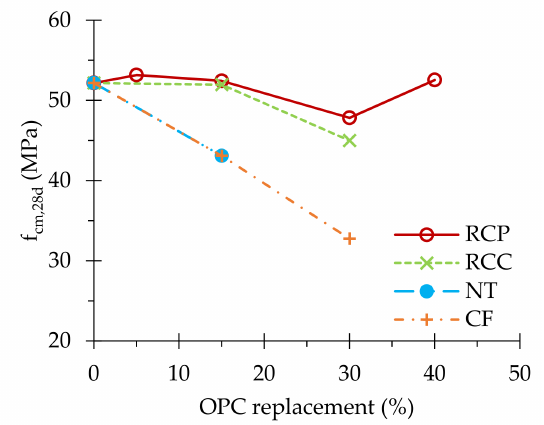
Figure 9. Compressive strength at 28 days, f cm ,28 d , of concrete with a w/b of 0.55 and different incorporation percentages of additions.